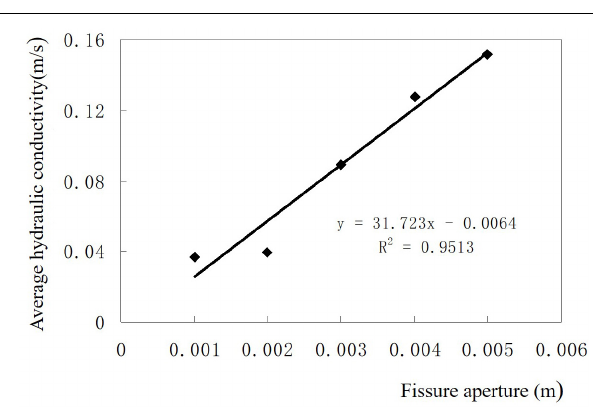
FIGURE 7 | The relationship diagram between the average hydraulic conductivity and conduit diameter.